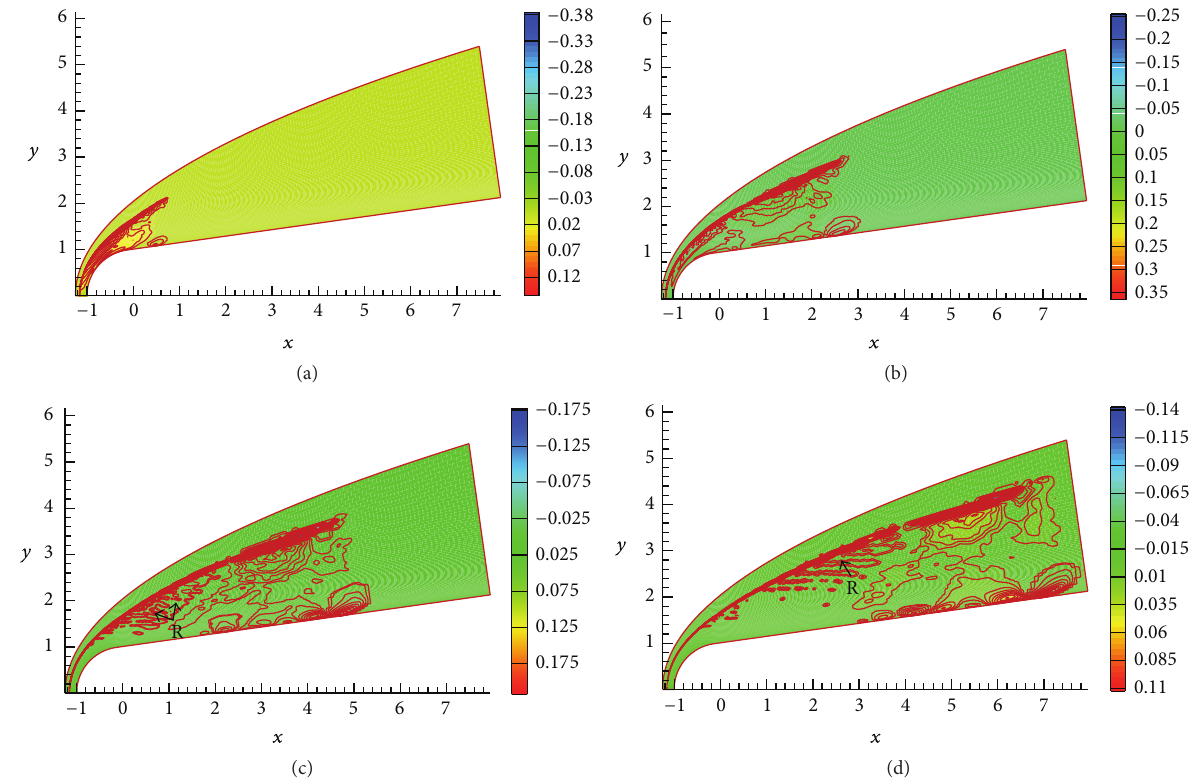
Figure 4: Contours of velocity disturbances along 𝑦 -axis V 󸀠 (𝑥,𝑦, 𝑡) at different